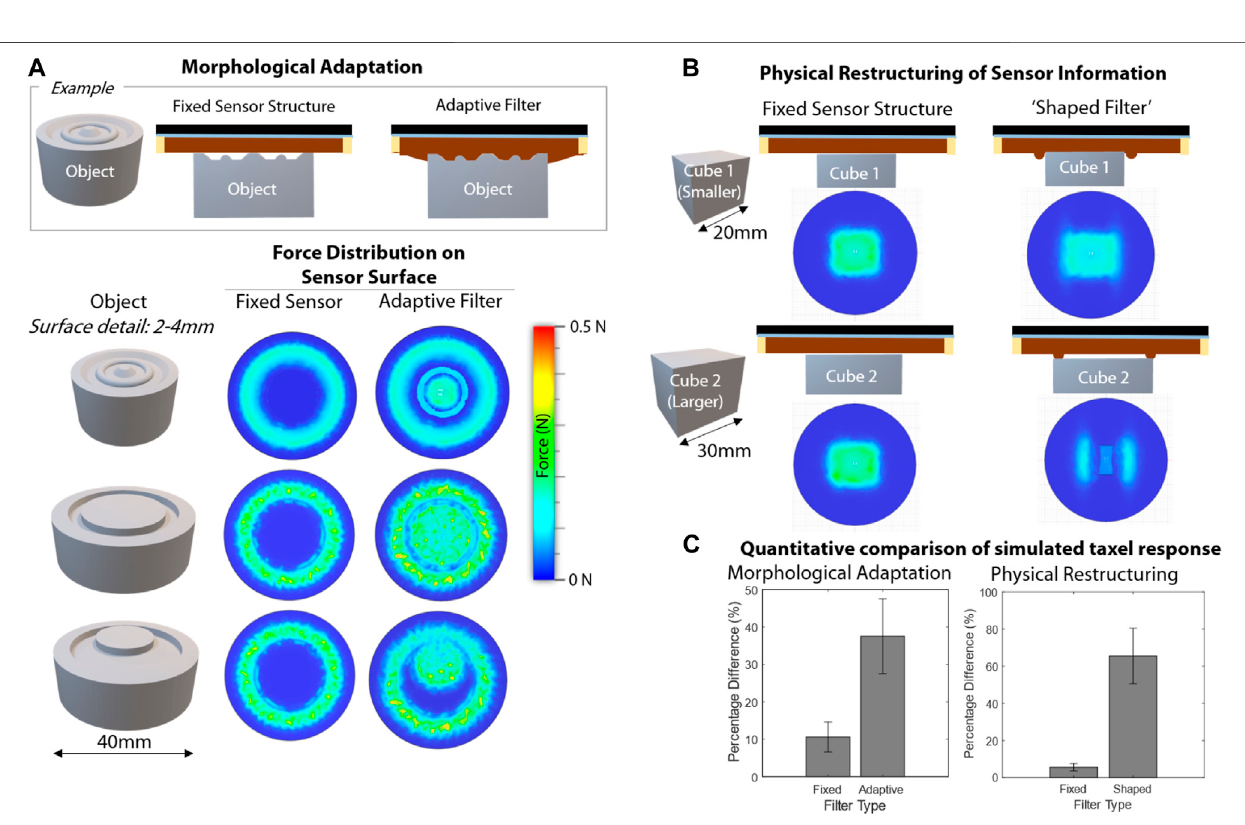
Frontiers in Robotics and AI |